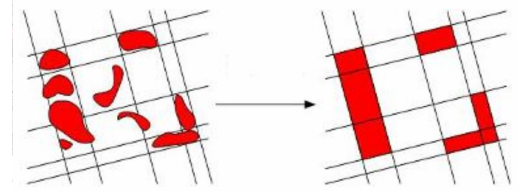
Figure 6. Building area labeling.